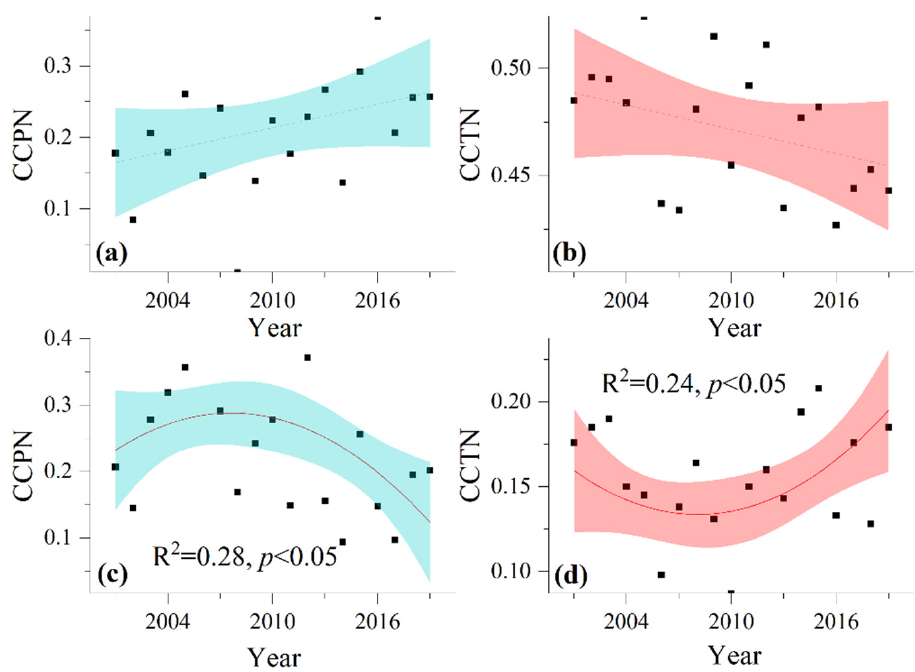
Figure 6. The effects of precipitation ( a ) and temperature ( b ) on the NPP in relatively humid regions from 2001 to 2019, and the effects of precipitation ( c ) and temperature ( d ) on the NPP in relatively arid regions from 2001 to 2019.